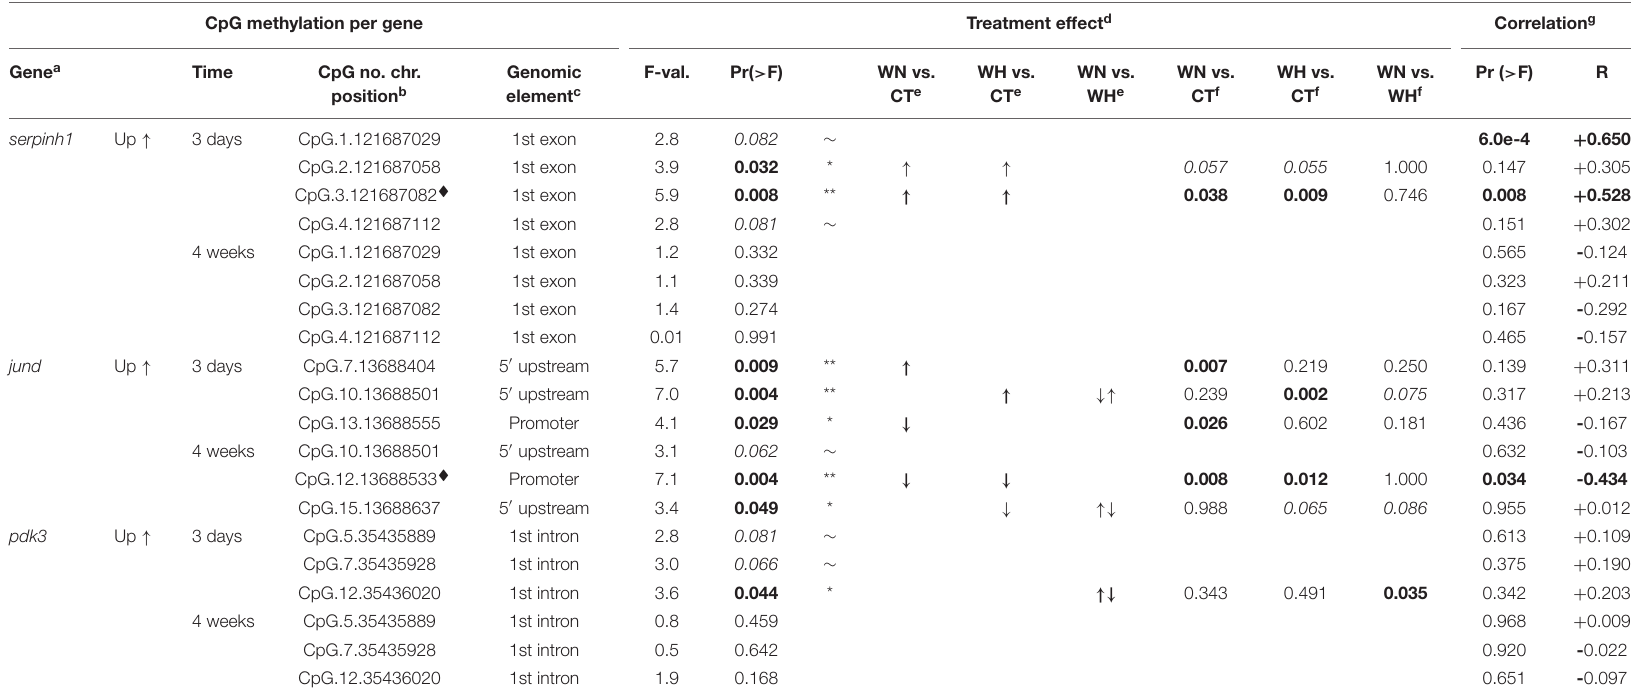
TABLE 2 | CpG methylation and relationship to the transcript expression of six genes ( cirbp , jund , pdk3 , prdx6 , serpinh1 , and ucp2 ) assessed by linear mixed-effect models ( lmer ) and correlation analyses. CpG methylation per gene Treatment effect d Correlation g Gene